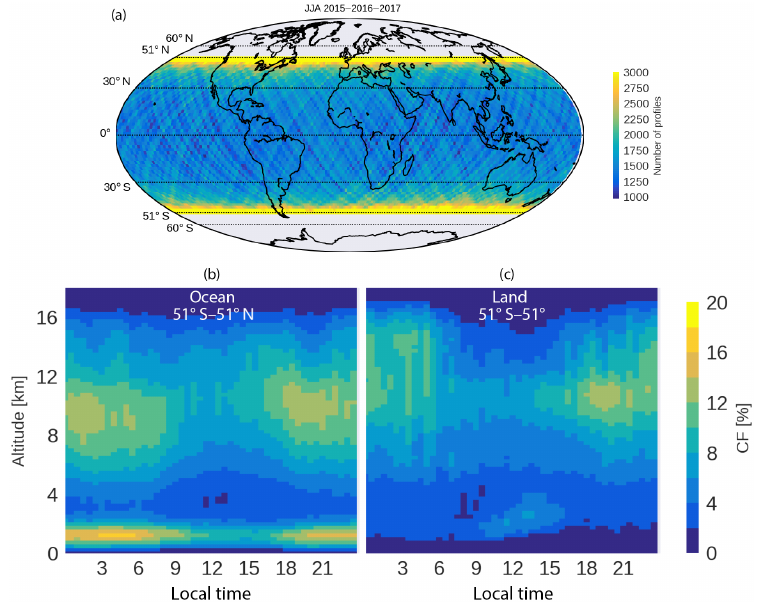
Figure 1. (a) Number of CATS profiles in 2 ◦ × 2 ◦ longitude–latitude boxes sampled during JJA 2015–2016–2017, with unsampled latitudes in grey. (b, c) Evolution of the vertical profile of cloud fraction as a function of local time of observation over the ocean (b) and land (c) , using CATS detections made in JJA from 2015 to